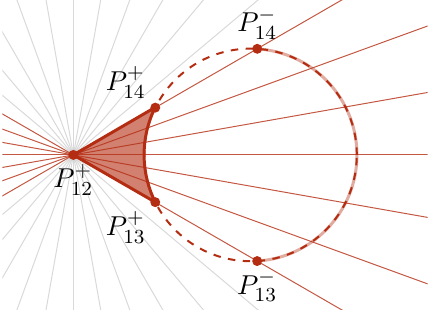
. All the 1 -faces live on lines Figure 13 . Contour on CP 2 after rationalization with respect to P − 12 through P + , except for P + (which is dual to P + ). This unique 1 -face is restricted to a quadric P + 12 13 14 12 (represented by the dashed curve), which is in fact the image of Q ∩ V . Detailed geometry of 1 V 3 V 4 this 1 -face is encoded in the solution y + in (4.25). The other solution y − corresponds to a path 2 2 linking P − and P − , and is not the actual 1 13 14